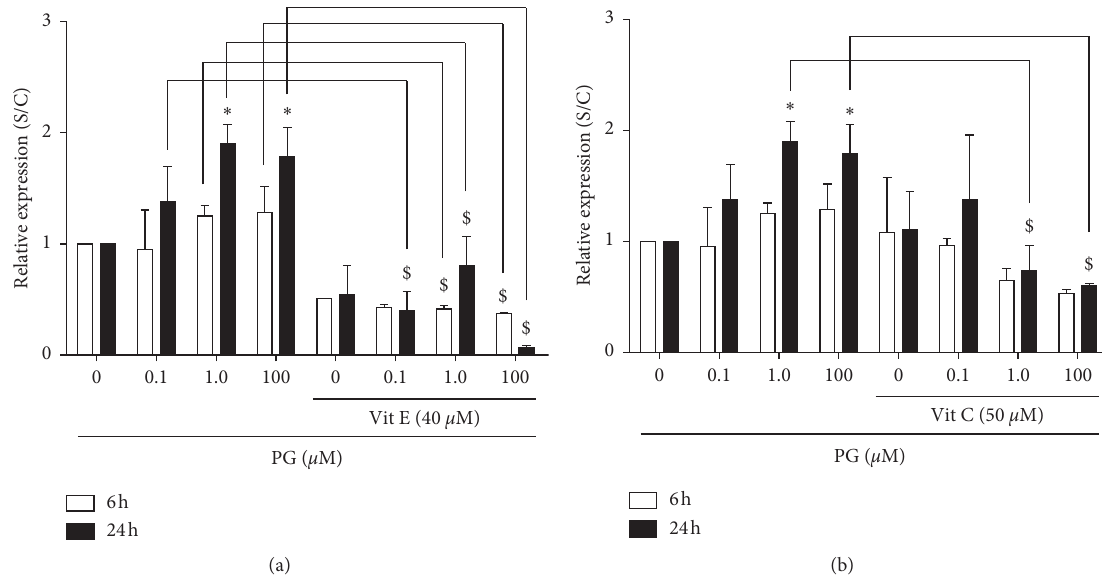
Figure 4: Expression of Scd1 gene in progesterone-treated RINm5Fcells, in the presence of antioxidants. Cells were preincubated with 40 μ M vitamin E (a) or 50 μ M vitamin C (b) for 2 h, and then with 0.1, 1.0, or 100 μ M progesterone 6 or 24h. Data are presented as means ± SEM of three experiments in duplicates. ∗ indicates difference compared to control. # indicates difference between the incubation time points, for the same progesterone concentration. $ indicates difference in comparison to the treatment without antioxidants ( ρ < 0.05). PG: progesterone; Vit E: vitamin E; Vit C: vitamin C.